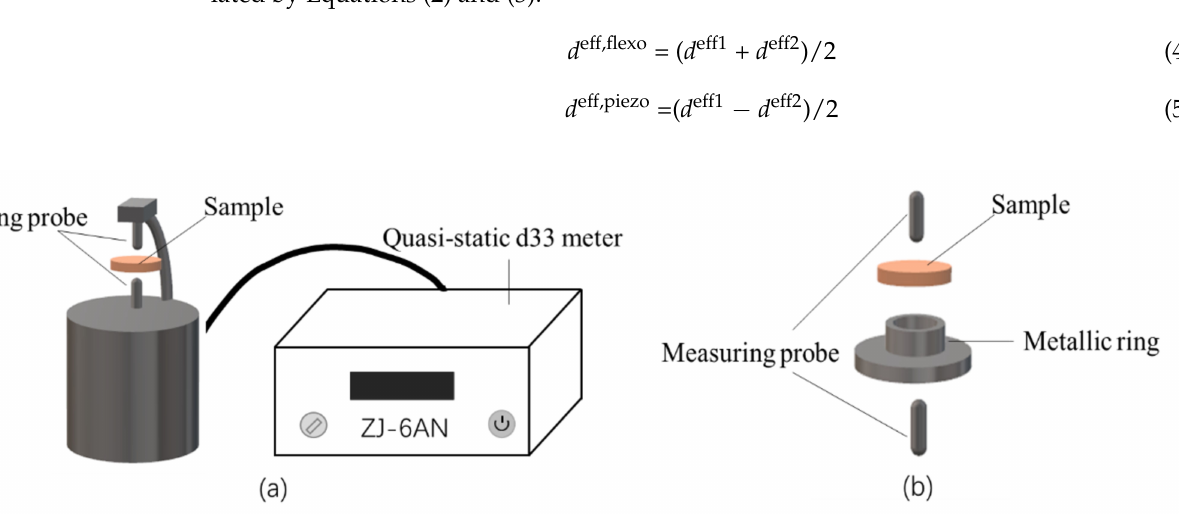
Figure 1. Schematics of ( a ) piezoelectric testing by quasi-static d 33 meter and ( b ) point-ring